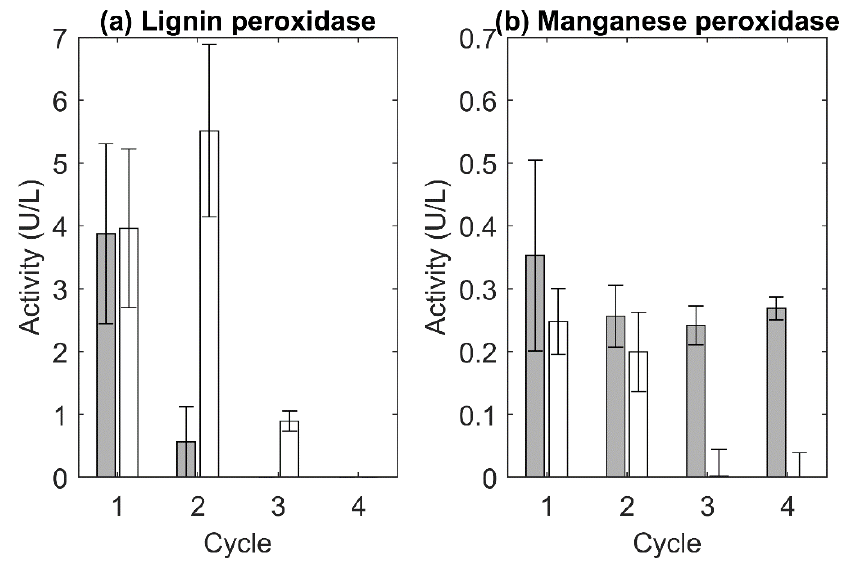
Figure 6. Ligninolytic enzyme activity for ( a ) lignin peroxidase and ( b ) manganese peroxidase in each cycle for R. kratochvilovae ( ■ ) and C. oleaginosum (□). The activities are the average of three each cycle for R. kratochvilovae ( (cid:4) ) and C. oleaginosum ( (cid:3) ). The activities are the average of three analytical repeats, the error bars present the standard deviation. analytical repeats, the error bars present the standard